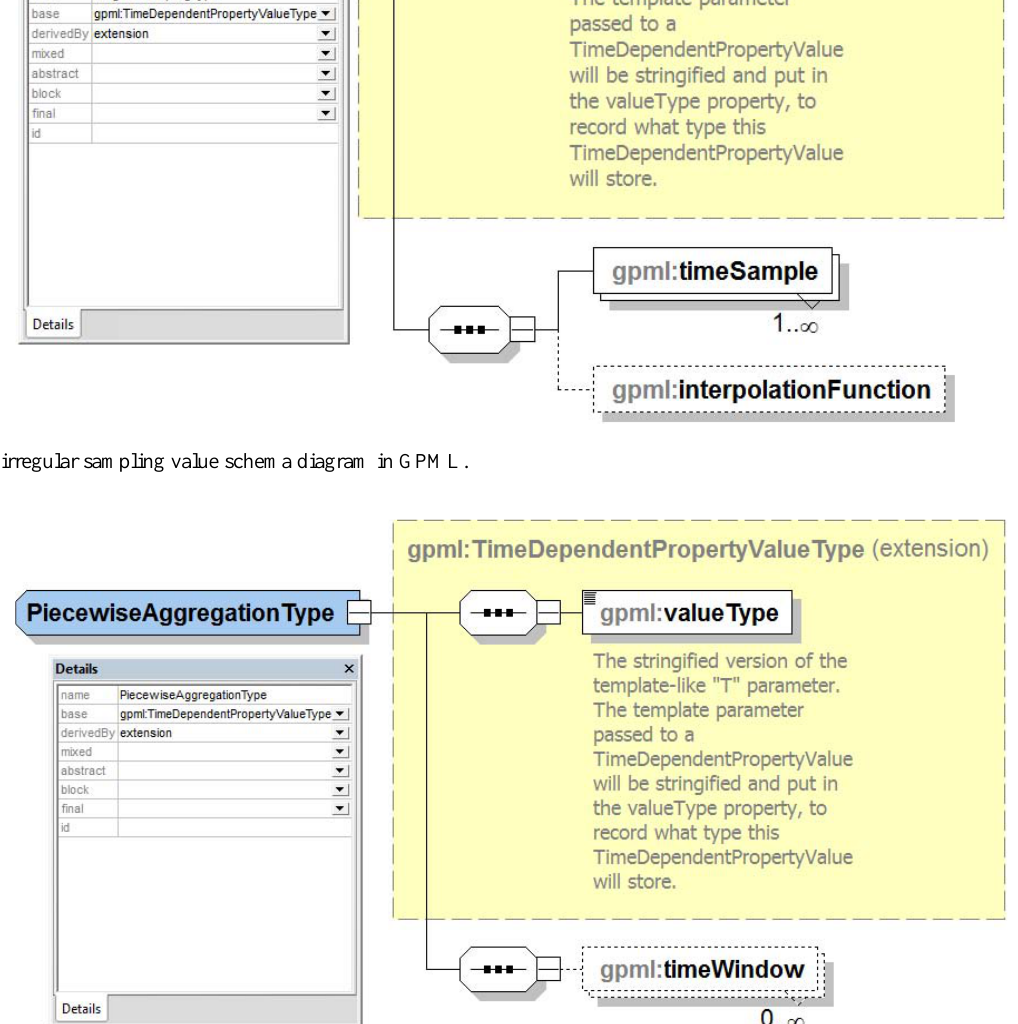
Fig. 15. The piecewise aggregation value schema diagram in